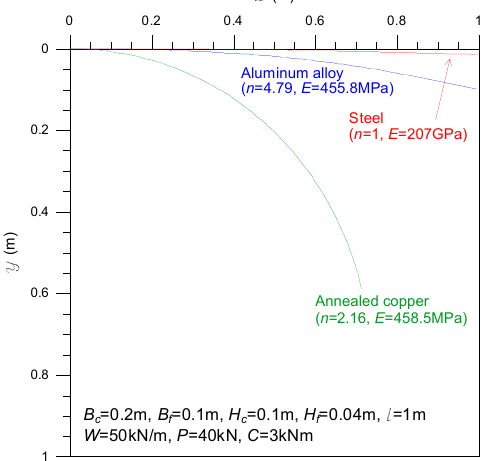
Figure 7. Elastica of steel, aluminum alloy, and annealed copper beams.